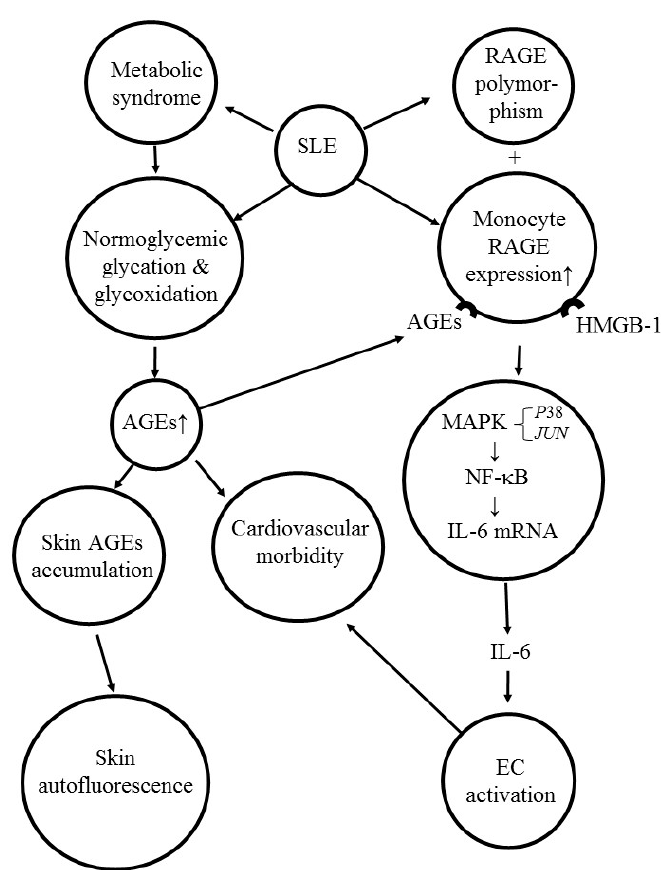
Figure 4. The molecular basis of AGE / RAGE activation in inducing skin autofluorescence, endothelial cell damage, and IL-6 gene expression in patients with SLE. HMGB-1: High mobility group box 1 protein; AGE: Advanced glycation end-product; RAGE: Receptor for AGE; MAPK: Mitogen activated protein kinase; JUN : Gene for ju-nana oncogene; NF- κ B: Nuclear factor of kappa-light-chain-enhancer of activated B cells; EC: Endothelial cell.